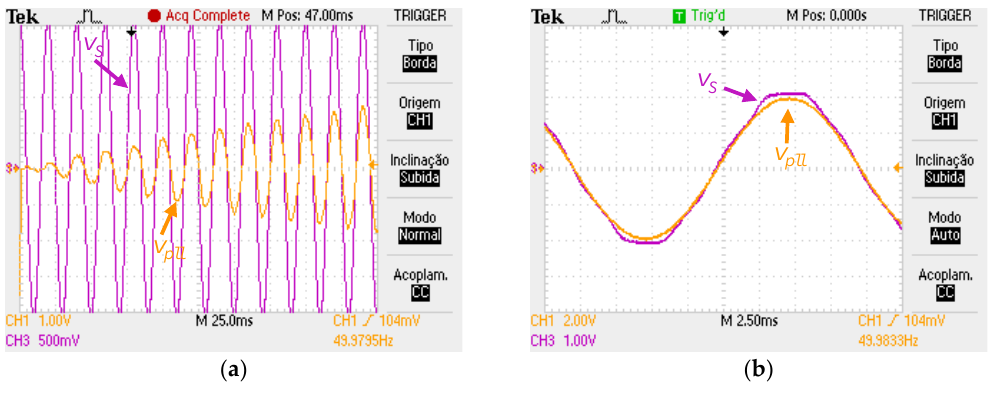
Figure 21. Experimental results of the Phase-Locked Loop (PLL) control algorithm: ( a ) PLL synchronization transient; ( b ) PLL in steady state.